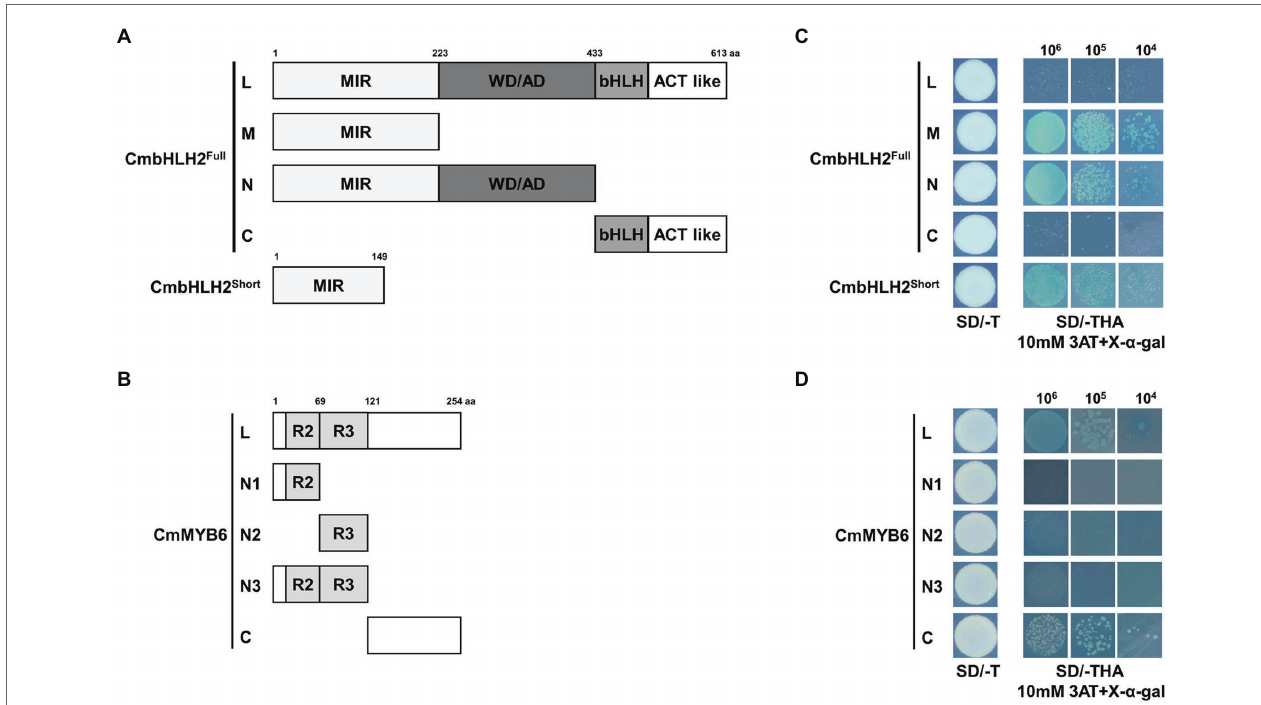
FIGURE 5 | Transactivation assay of CmbHLH2 Full , CmbHLH2 Short , and CmMYB6. (A) Schematic diagrams of CmbHLH2 Full and CmbHLH2 Short constructs used in the transcriptional activity assay. (B) Schematic diagrams of CmMYB6 constructs used in the transcriptional activity assay. (C) Transactivation assay of full-length CmbHLH2 Full and relevant truncated proteins and CmbHLH2 Short in yeast. (D) Transactivation analysis of full-length CmMYB6 and relevant truncated proteins in yeast. Amino acid positions are labeled in the diagrams. SD, minimal medium; AD, activation domain only; BD, binding domain only; 3AT, 3-amino-1,2,4-triazole; SD/ − T, minimal medium lacking Trp; SD/ − THA + X- α -Gal, minimal medium lacking Trp, His, and Ade but containing 20 mg/ml X- α -Gal; 10 6 , 10 5 , and 10 4 indicate the number of cells dotted on each plate of the